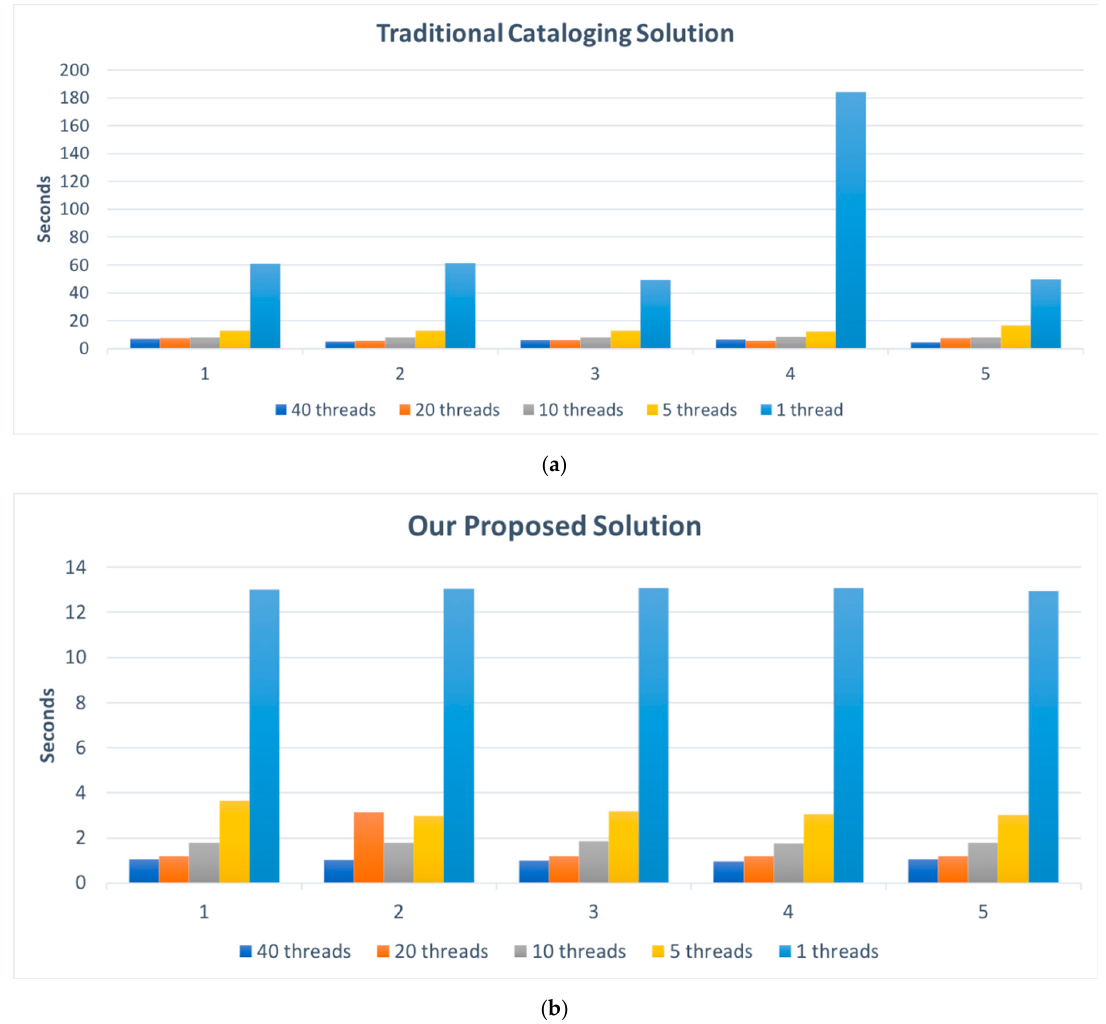
Figure 16. Performance comparison (time in seconds) of the traditional harvesting approach ( a ) and our approach ( b ), sampled 5 times for crawling 125 records.